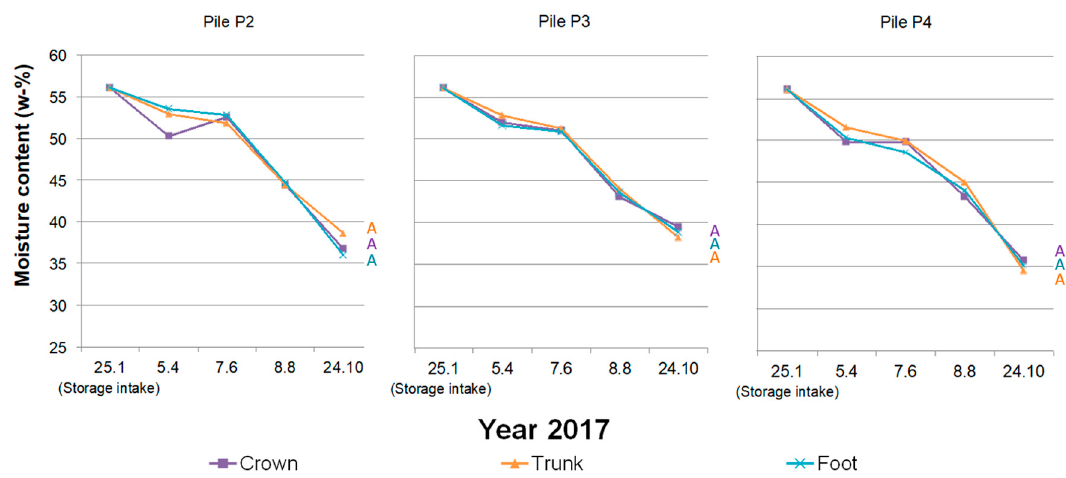
Figure 12. Moisture content in Schwarzbach (top - bottom) (Different letters indicate significant differences between treatments for α = 0.05, F-test).